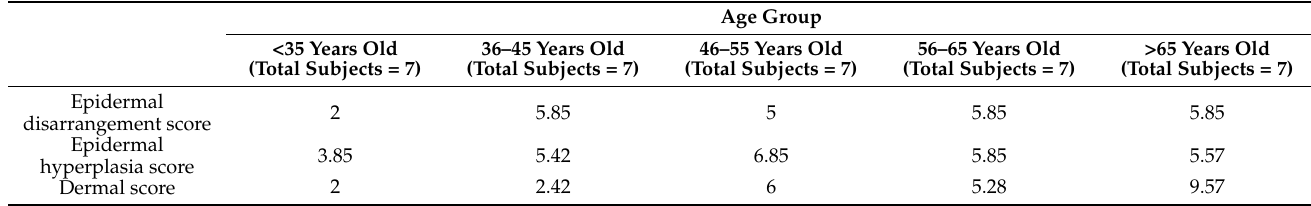
Table 6. Components of CSIESA score based on age groups.